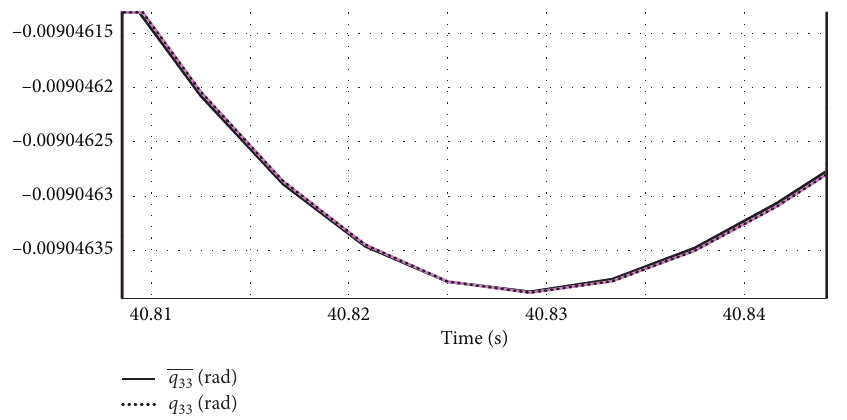
Figure 25: Close up of Figure